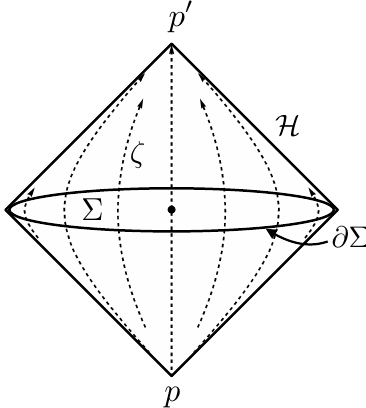
Figure 1: A causal diamond in a maximally symmetric spacetime for a ball-shaped spacelike region Σ . The past and future vertices of the diamond are denoted by p and p (cid:48) , respectively, and is the null boundary. The dashed arrows are the flow lines of the conformal Killing H vector ζ , whose flow sends the boundary of the diamond into itself, and vanishes at ∂ Σ , p and p (cid:48)